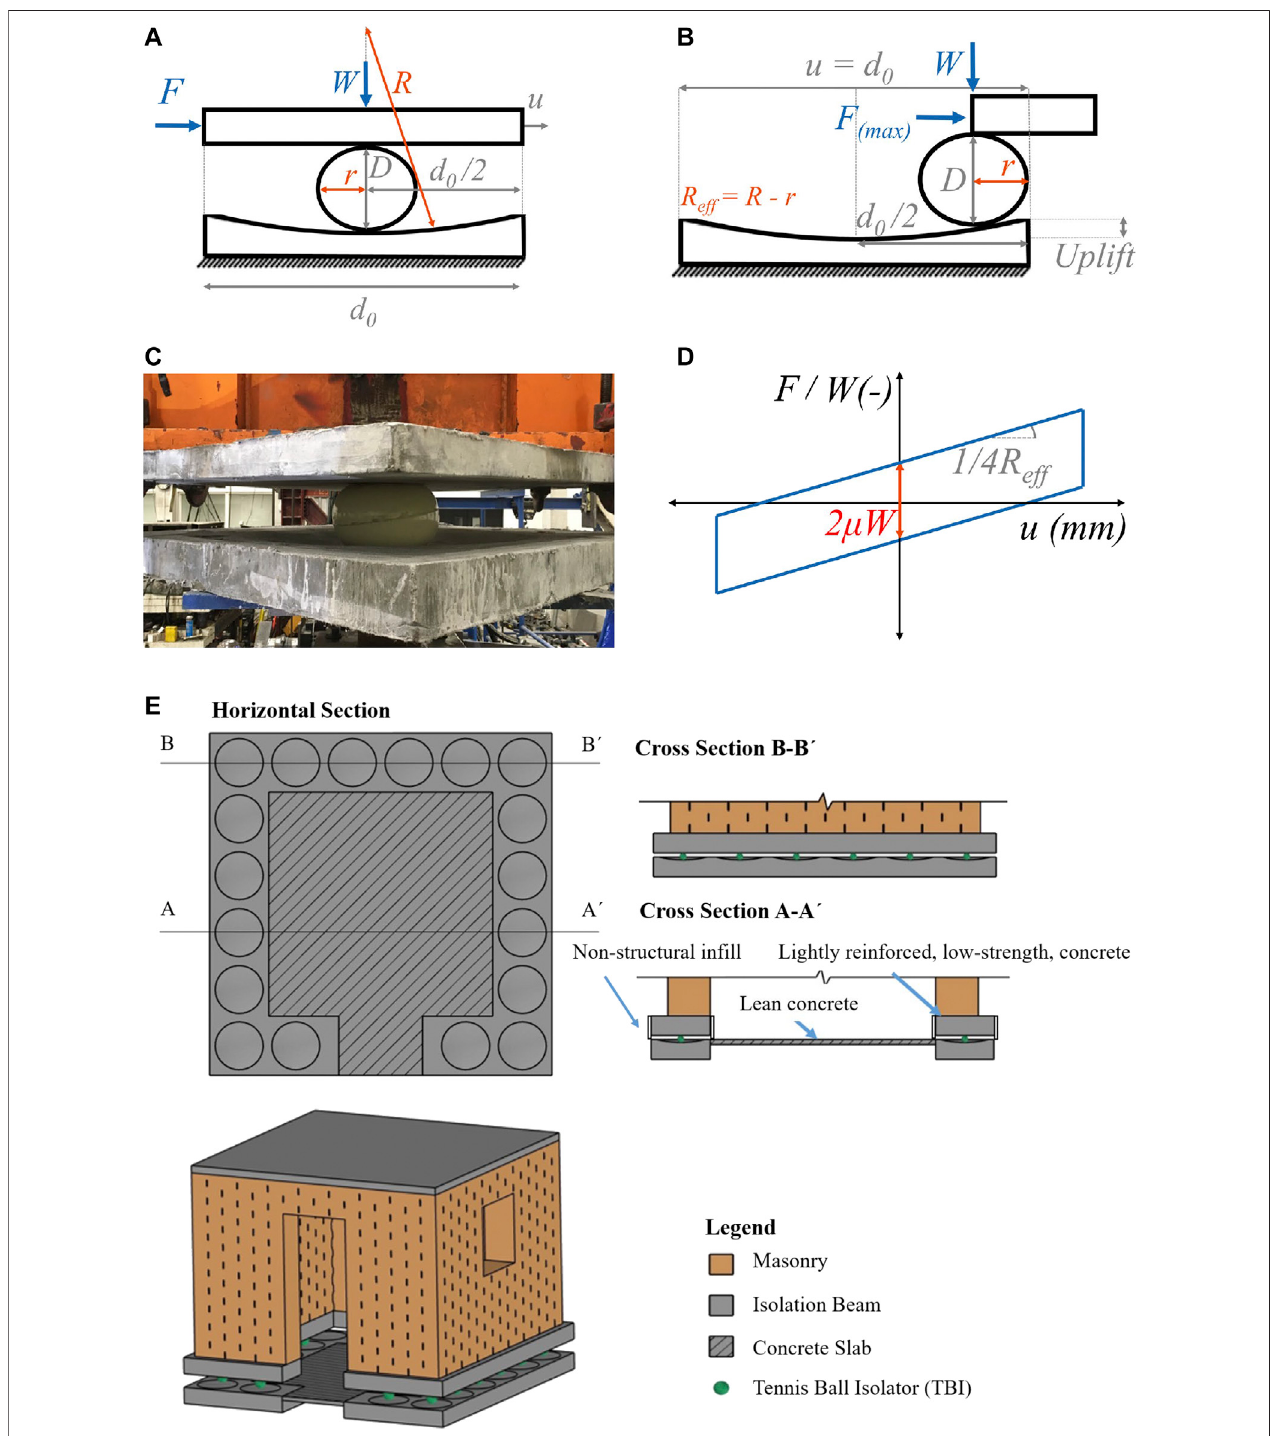
FIGURE 1| Spherical Deformable rolling isolator. (A) Under compression, (B) Under compression and lateral load, (C) During testing by Cilsalar and Constantinou (2019a); Cilsalar and Constantinou (2019b); Cilsalar and Constantinou (2019c), (D) Bilinear force-displacement plot, (E) Potential application of the tennis ball isolator (TBI) proposed in this study.